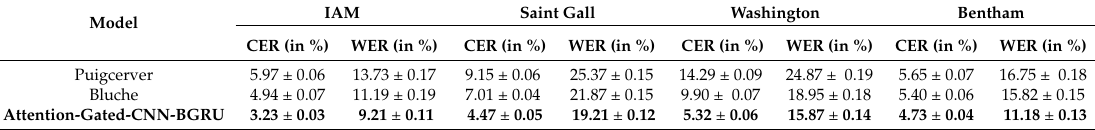
Table 7. The effect of data augmentation and batch normalization on other datasets. Model IAM Saint Gall Washington Bentham